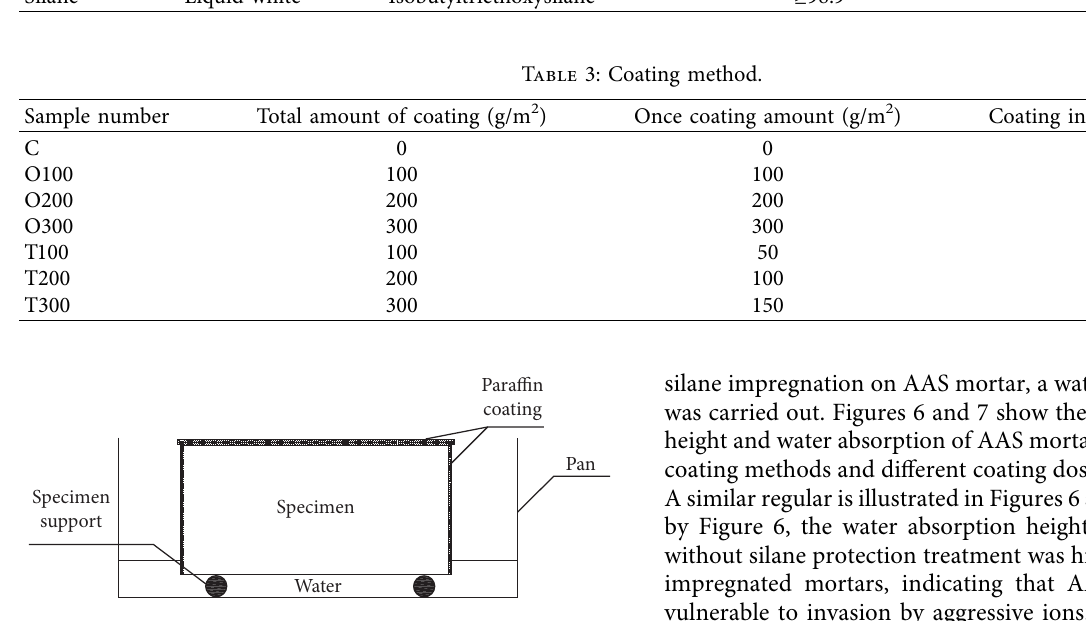
Figure 5: Schematic of water absorption test